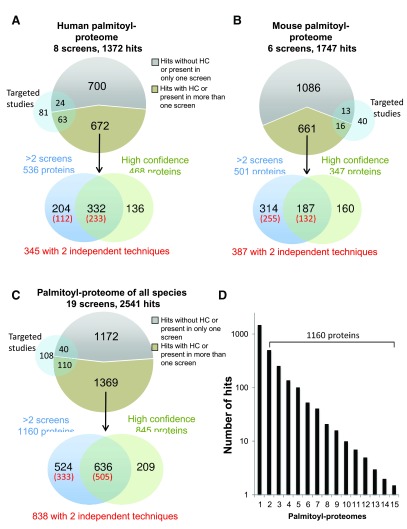
Improved confidence in S-palmitoylation protein hits.
A: Analysis of the 1372 human hits contained in 8 palmitoyl proteomes: 672 S-palmitoylation hits are present in at least 2 human palmitoyl proteomes or are annotated as “high confident hits” (HC). 204 are only found in at least 2 human palmitoyl proteomes, 136 are only classified as HC and 332 S-palmitoylation hits are both found in more than one palmitoyl-proteome and classified as HC. Out of the 672 hits, 345 are identified with 2 independent techniques. 63 out of the 672 S-palmitoylation hits have been validated in targeted studies, while 24 out of 700 hits only found in 1 human palmitoyl proteome have been validated.
B: Analysis of the 1747 mouse hits contained in 6 palmitoyl proteomes as described in
A.
C: Analysis of the 2541 human orthologous hits contained in 19 palmitoyl proteomes as described in
A.
D: Number of the S-palmitoylation hits by the occurrence of palmitoyl-proteomes in which they have been identified.